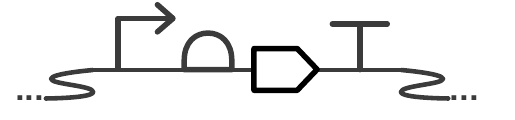
Figure 43: A functional unit consisting of promoter, ribosome entry site, CDS, and terminator, all integrated together into the chromosome.